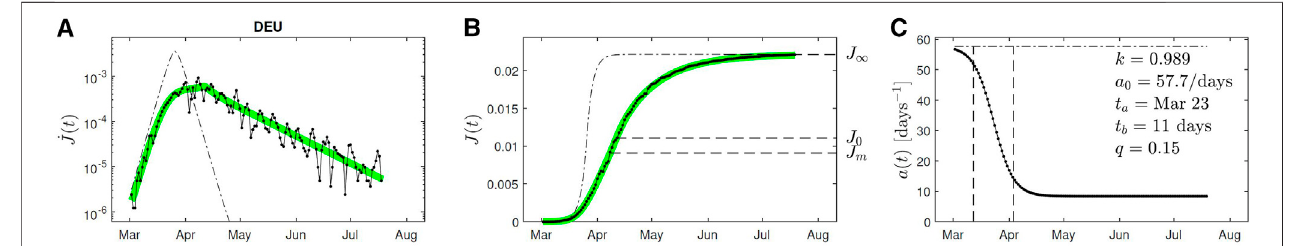
FIGURE5|(A) Measureddata _ J ( t ) ofnewdailyinfectedfraction(blackcircles)forGermany(DEU)comparedwiththemodel _ J ( t ) (cid:2) a ( t ) j ( τ ( t )) outlinedhere(green). Shown for comparison is the case where no NPIs are imposed ( q (cid:2) 1, black dot-dashed). (B) The measured cumulative fraction J ( t ) (black circles) together with the modelprediction(green),andthereference q (cid:2) 1case.Alsodepictedare J 0 andthevalueatpeaktime, J m . (C) Theinfectionrate a ( t ) correspondingtothecurvesshown in (A) and (B) . Model parameters mentioned in the fi gure; a dropped from an initial value of x 58/days down to 7.8/days during the 2nd half of march. This realized case can be directly compared with the four hypothetic cases shown in Figure 4 . For details on how to obtain the parameters see Appendix G